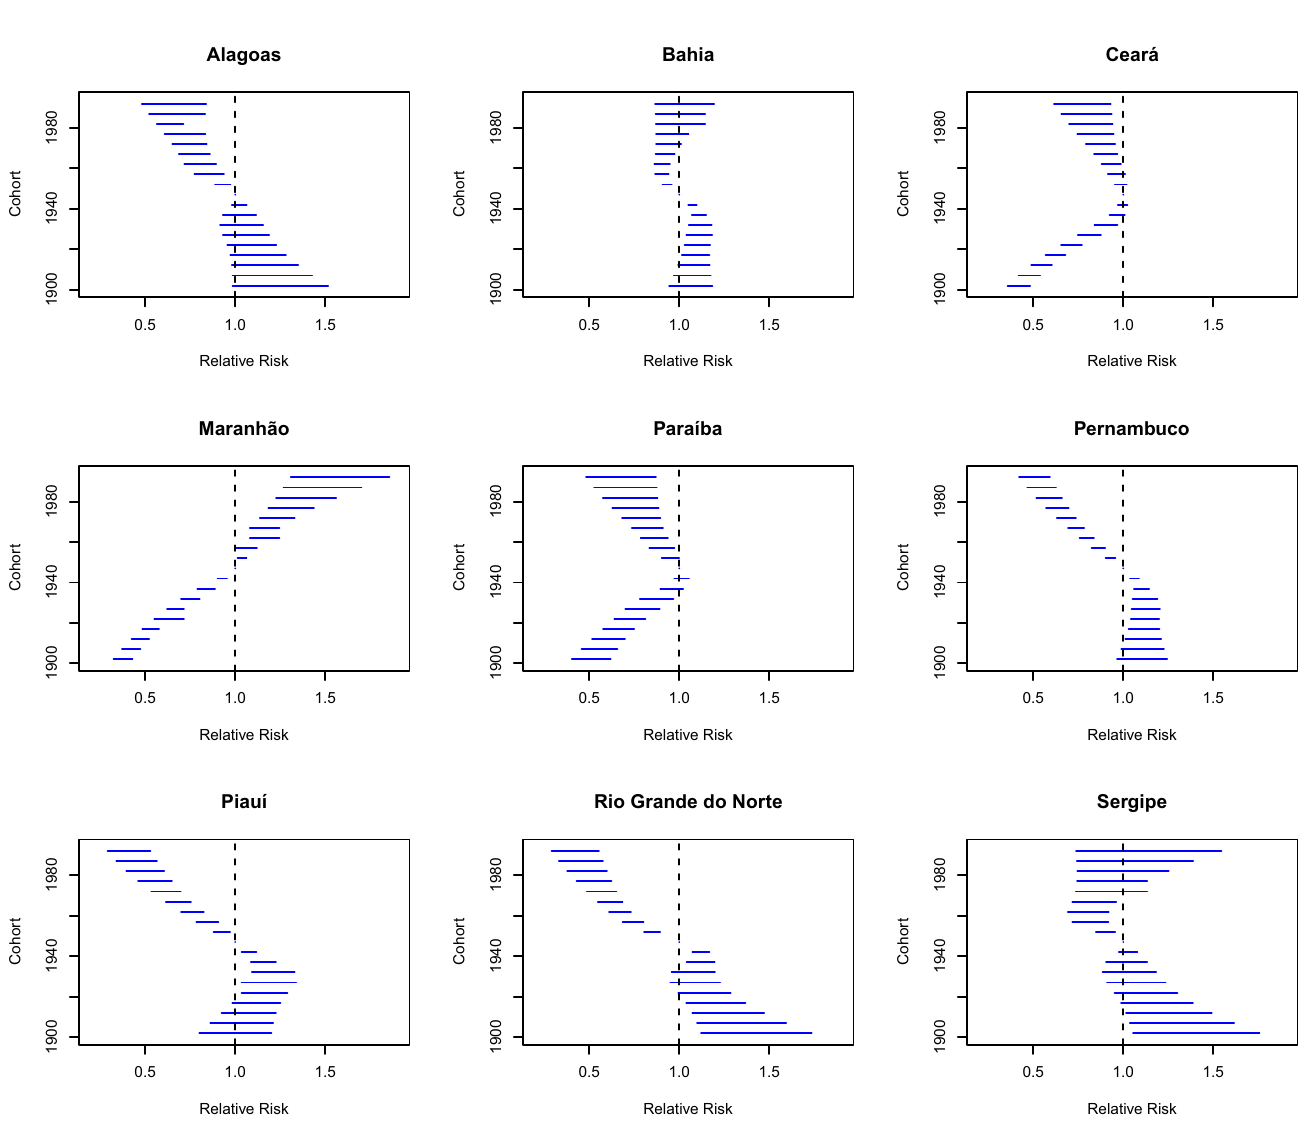
Fig 8. Results of the age-period-cohort model adjusted for cervical cancer mortality according to the cohort effect in northeastern states, Brazil, 1980–2014.